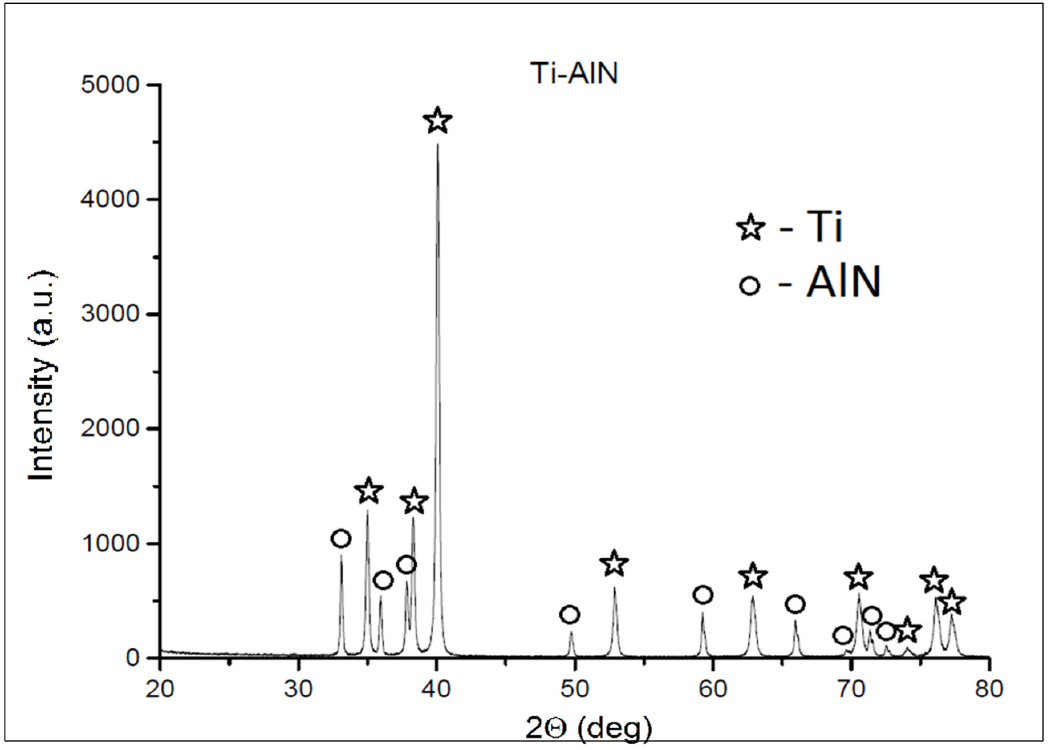
ff raction pattern of the Ti and AlN powder Figure 3. Diffraction pattern of the Ti and AlN powder mixture. Figure 3. Di